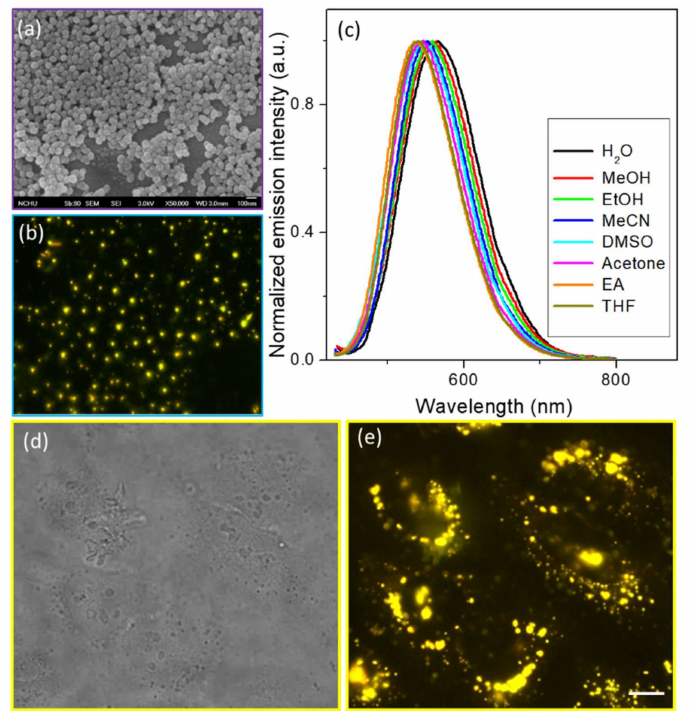
Figure 5. ( a ) SEM images (scale bar 100 nm); ( b ) fluorescence microscopy image (Ex: 390 ± 20 nm bp